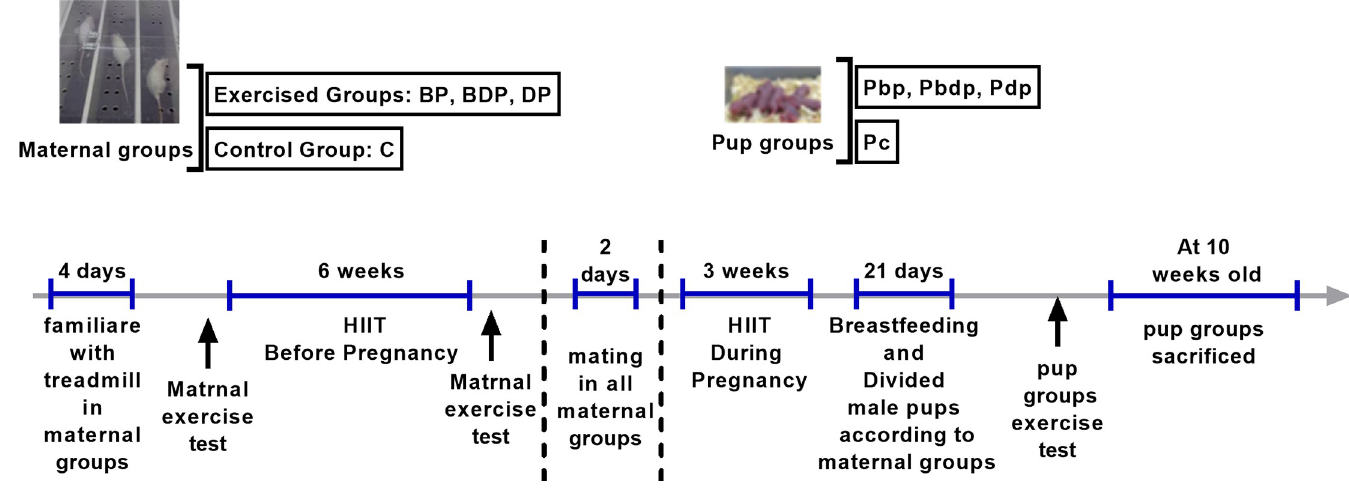
Fig 1. Schematic experimental design of the study.